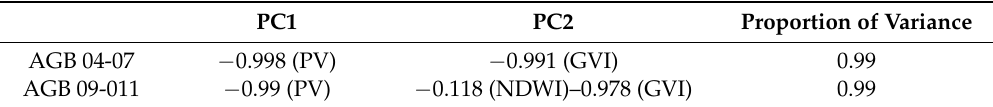
Table 4. Principal components used for AGB estimations.